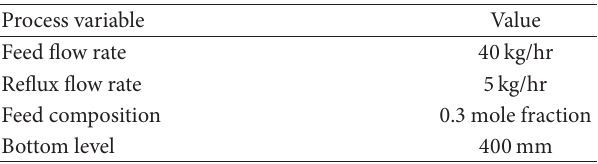
Table 5: Steady state operating conditions of the packed bed distil- lation